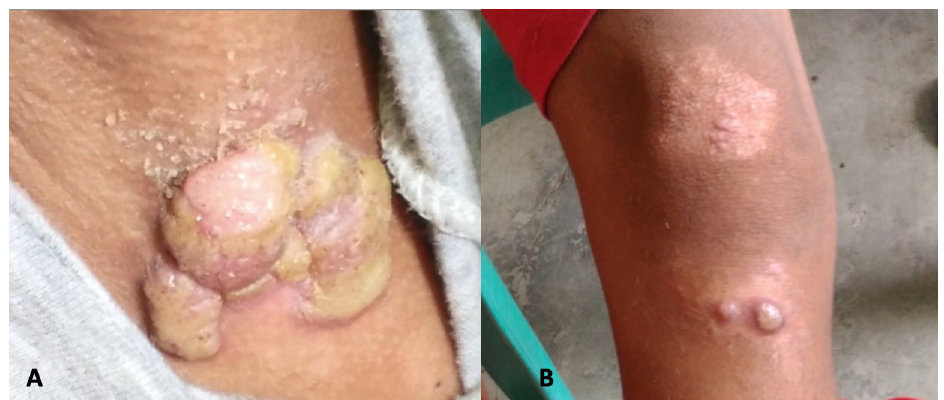
Fig 2. Index yaws case: 10 year old boy with large, “moist cauliflower” papillomas on left axilla (A), papulosquamous plaque and yellow-crusted nodules of secondary yaws on the leg (B) [9].